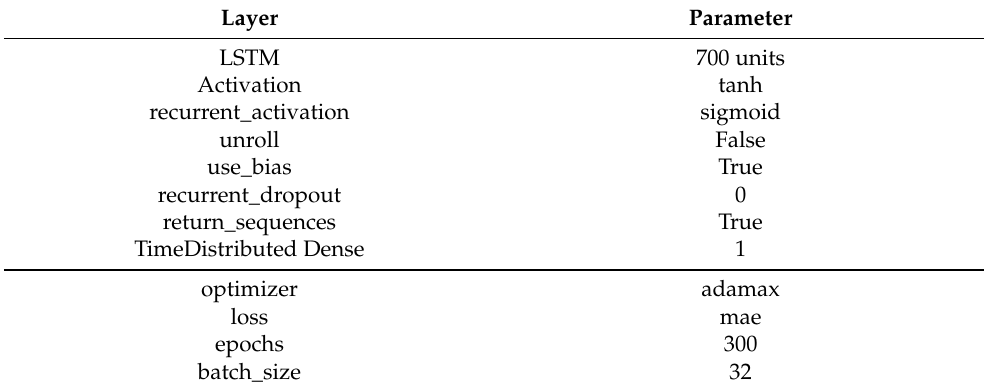
Table 1. Parameters of the LSTM neural network.